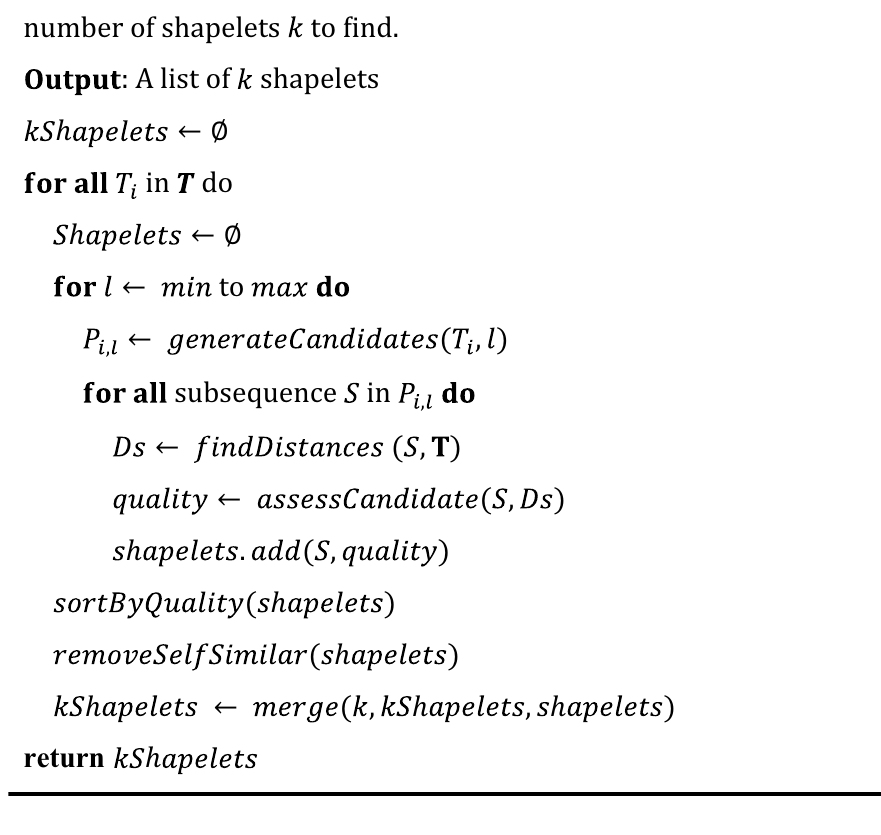
Algorithm 2 ShapeletTransform(Shapelets S, Dataset T